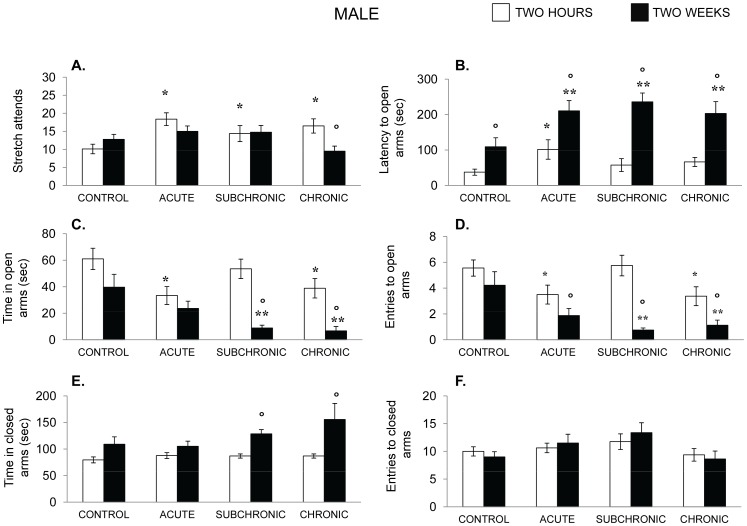
Effects of chronic, subchronic-intermittent and acute stressors on anxiety-related behaviors in male mice.Mean (± SEM) stretch attend responses (A), latency to enter the open arms (B), Time in the open Arms (C), Number of entries into the open arms (D), Time in the closed arms (E) and number of entries into the closed arms 2 he and again 2 weeks following treatment. Male mice had either not been stressed (control), exposed to an acute stressor (resident intruder paradigms for the two sexes), a subchronic-intermittent stressor followed by the resident-intruder paradigm, or a chronic stressor followed by the resident-intruder stressor. *p<.05 relative to nonstressed mice. o p<.05 relative to performance measured 2 hr following the treatment.